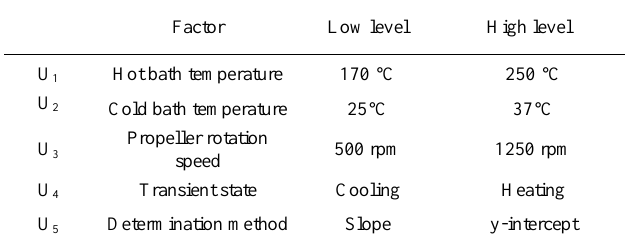
TABLE V: I NFLUENCE FACTORS Factor Low level